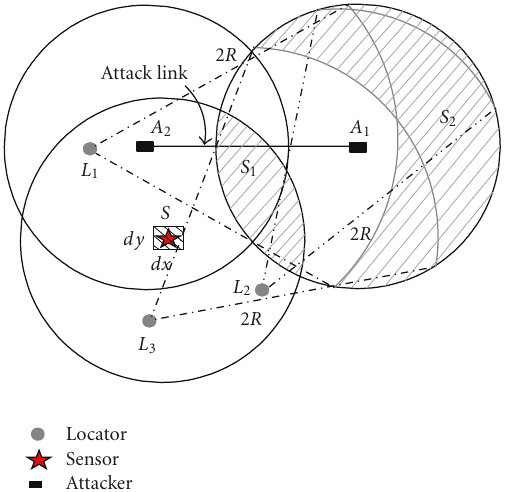
Figure 3: Theoretical analysis of the mathematical probability under the distance-consistent spoofing attack.